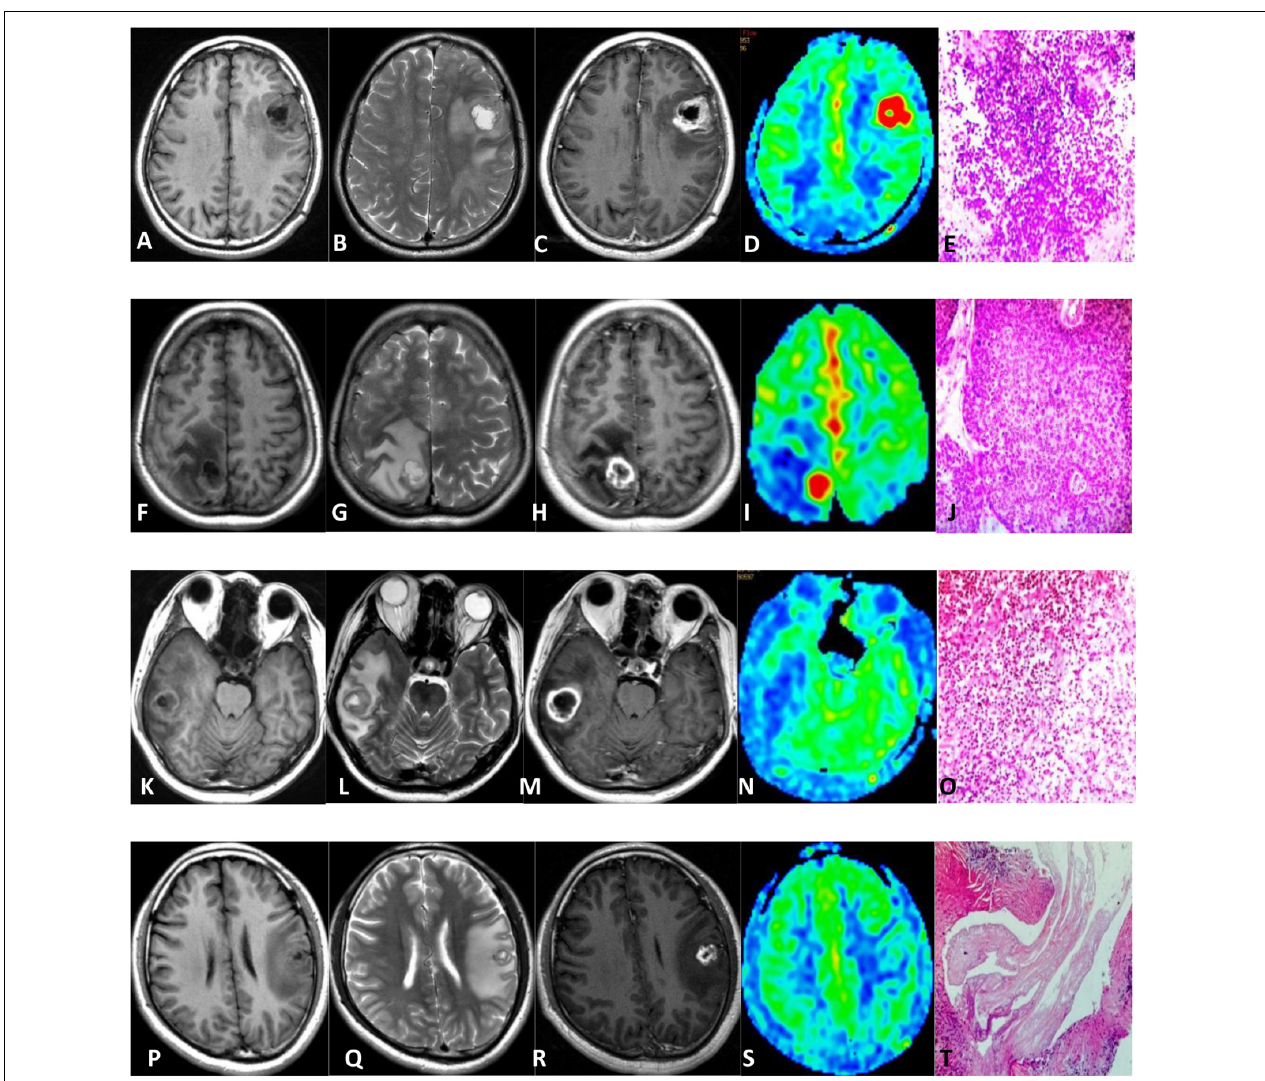
FIGURE 1 | Comparison of HGG (A–E) , metastasis (F–J) , brain abscess (K–O) , and cerebral cysticercosis (P–T) . First row: 64-year-old male with an HGG in the left frontal lobe; unenhanced MR scan showed hypointense on T1WI and hyperintense onT2WI (A,B) . The contrast-enhanced T1-weighted MRI showed ring enhancement (C) . 3D-pCASL exhibited as hyper-perfusion in the region of tumor compared with the contralateral brain (D) . Pathologically, the tumor cells were diffusely distributed and showed increased density (E) . Second row: 42-year-old woman with a metastatic tumor in the right parietal lobe; MR plain scan showed hypointense on T1WI and hyperintense on T2WI (F,G) . The enhanced scan showed ring enhancement (H) . 3D-pCASL showed as hyper-perfusion in the region of metastasis (I) . Pathology showed the nested atypical cells, which was squamous cell carcinoma (J) . Third row: 40-year-old man with a brain abscess in the right temporal lobe. MR plain scan showed hypointense on T1WI and hyperintense on T2WI (K,L) . The enhanced scan showed ring enhancement (M) . 3D-pCASL showed the lesion demonstrated as hypo-perfusion (N) . Pathology showed lymphocyte, neutrophil infiltration, abscess formation, and granulation tissue hyperplasia (O) . Fourth row: 28-year-old man with cerebral cysticercosis in the left frontal and parietal lobe. MR plain scan showed hypointense on T1WI and hyperintense on T2WI (P,Q) . The enhanced scan showed ring enhancement (R) . 3D-pCASL showed that the lesion was iso-hypo-perfusion (S) . Pathologically, lace-like parasites can be seen (T)